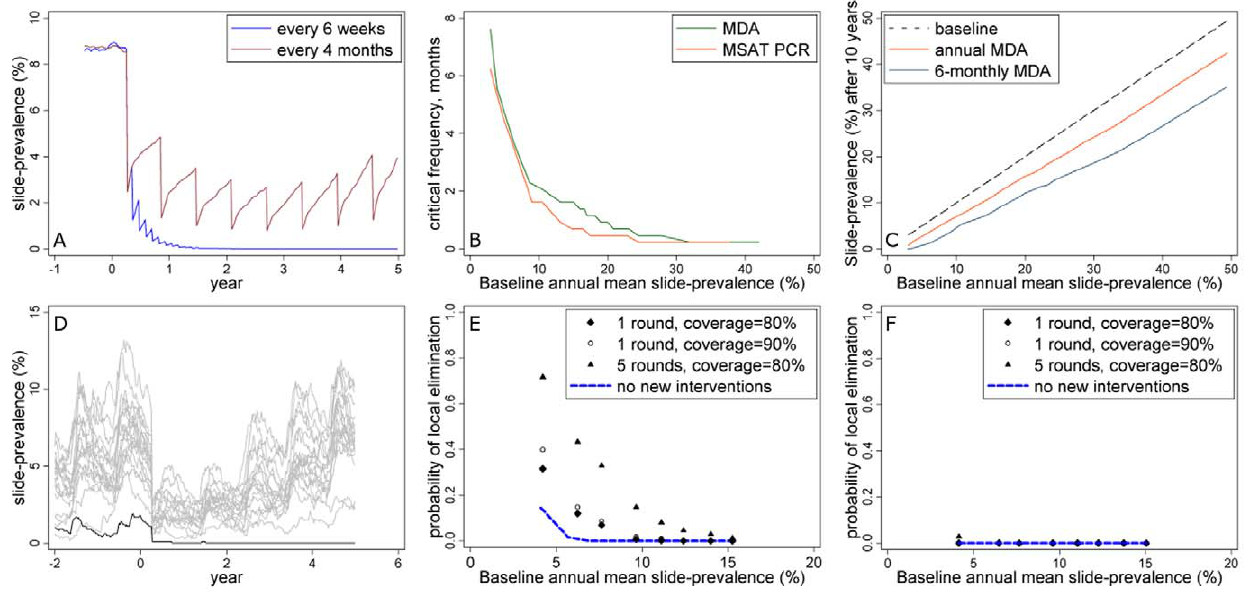
Figure 3. Potential for elimination by mass treatment. (A) Example simulation of a mass treatment programme in a non-seasonal scenario where multiple rounds of MDA are carried out, and the interval in between treatment rounds is less (every 4 months) or more (every 6 weeks) than the critical interval required to achieve , 0.1% slide prevalence. (B) Model-estimated minimum frequency of mass treatment required in a large population to bring slide-prevalence to 0.1% or less for at least 50 consecutive days in non-seasonal settings: MDA versus MSAT with PCR as a screening tool. (C) Model-estimated annual mean slide-prevalence after 10 years of MDA repeated every year or every 6 months, according to baseline slide-prevalence prior to intervention. Moderate seasonality is assumed (see Figure 2A). D) example stochastic simulations of transmission over time assuming a small human population (n=1000) with 1 round of MDA before the peak transmission season in year 1. A single simulation in which MDA succeeds in eliminating infection locally is shown in black. E) and F) Model-estimated probability of local elimination at different transmission intensities in a population of (E) 1000 or (F) 10,000, following MDA of different intensities. Results are based on 500 stochastic realizations per plotted point. Moderate seasonality is assumed (see Figure 2A). All simulations in this figure assume a low level of vector control at baseline which is maintained over time (the baseline slide-prevalence shown is in the presence of vector control).